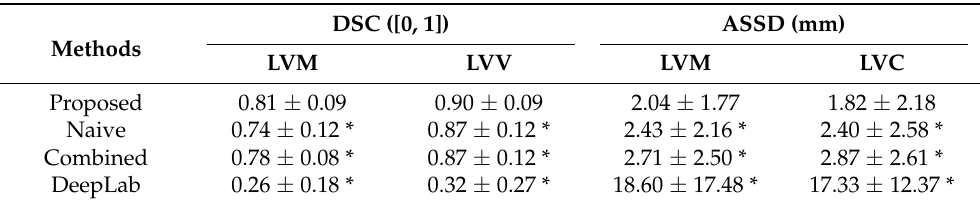
Table 1. LV myocardium and cavity segmentation accuracy (mean ± SD) for n = 180 images from 90 previously unseen ACDC test subjects.